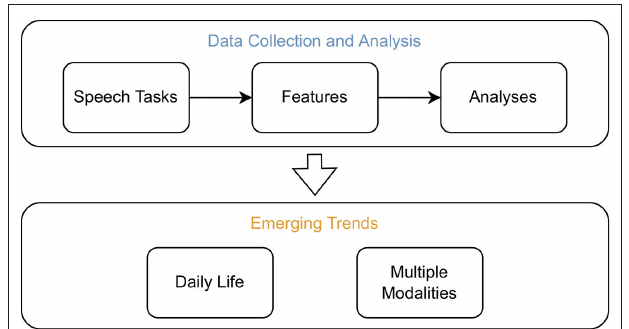
FIGURE 1 | Overview of the topics addressed within this review. Studies which recorded original datasets to assess neurological disorders from voice were screened. From those, information was extracted to assess which speech tasks are commonly employed, which methods are frequently used to extract features, and which analysis methods are prevalent. In addition, significantly correlating acoustic features in common psychiatric and neurodegenerative disorders were summarised. The emerging trends to record data in daily life and from multiple modalities were uncovered by screening for particularities in the recording setup of the retained